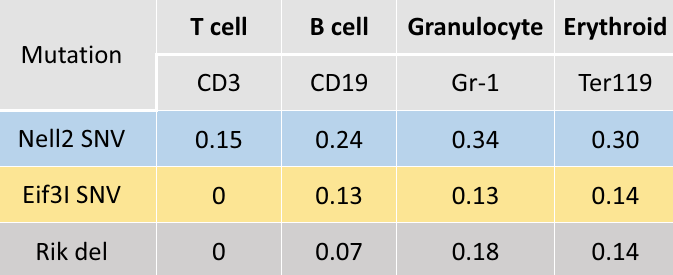
Figure 3. Distribution of CH-associated mutations in several tissues, BM blood cell types, and HSPC colonies in an irradiated mouse (mouse 33). ( A ) Schematic representation of experimental procedures for CH-associated mutations. ( B ) Nell2 SNV was considered to develop during early embryogenesis based on the VAFs of several non-hematopoietic organs, brain (Br), testes (Tes), and thyroid gland (Thyr). The Nell2 SNV was also prevalent in other non-hematopoietic blood-filtering tissues, tail, liver (Liv), and kidneys (Kid), BM, and lymphoid tissues, spleen (Spl) and thymus (Thym). Two separate sections for Thyr and Kid, three for Liv, and one for the other tissues were examined. Both the Eif3I SNV and 1700122O11Rik deletion (Rik del) showed limited distributions in these tissues (except for Spl). ( C ) In BM cells, the frequency of the Nell2 SNV was higher in B cells, granulocytes, and erythroid cells than in T cells. Both the Eif3I SNV and Rik del were frequent in BM cells, particularly in B cells, granulocytes, and erythroid cells. ( D ) Simplified illustration (left panel) shows coexistence of the Eif3I SNV and 1700122O11Rik del with the Nell2 SNV in hematopoietic colonies from HSCs and MPPs. Right panel depicts estimated proportions of clonal populations defined by recurrent mutations in BM nuclear cells of mouse 33, after irradiation. Clonal cell percentages were estimated by doubling the VAFs of the mutation in the BM, and their inclusion relationships were derived from the distribution of the three clonal mutations in HSPC colonies. BM, bone marrow; CH, clonal hematopoiesis; HSPC, hematopoietic stem/progenitor cell; SNV, single-nucleotide variant; VAF, variant allele